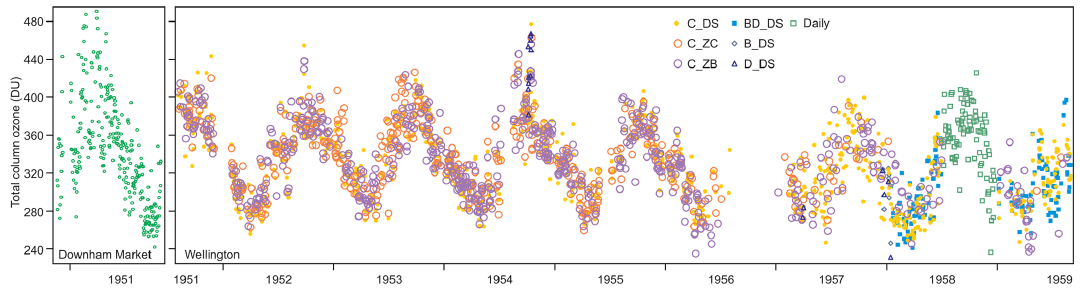
Figure 5. Total column ozone at Downham Market (1950–1951) and Wellington (1951–1959) for different wavelength pairs and observation modes (here for the case of Bass–Paur